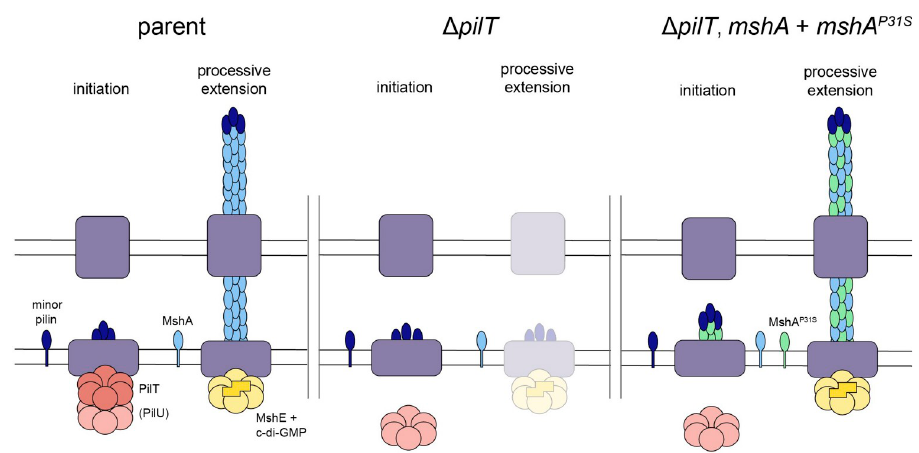
Fig 8. Model for the proposed mechanisms that promote MSHA extension and surface piliation. In wildtype cells (left), PilT promotes initiation of pilus extension, potentially by maturing the minor pilins into an initiation complex. Then, MshE can promote processive extension of the pilus in a c-di-GMP-dependent manner. The PilT-dependent accessory retraction ATPase motor PilU is dispensable for promoting pilus extension, but it can facilitate extension if PilT’s ATPase activity is inactivated. If PilT is absent (middle), initiation is inhibited, so processive extension is greatly diminished. Finally, mutations to the MshA major pilin (right), like MshA P31S , can promote initiation of MSHA extension even in the absence of PilT, suggesting that the structure of the major pilin is an important determinant of pilus